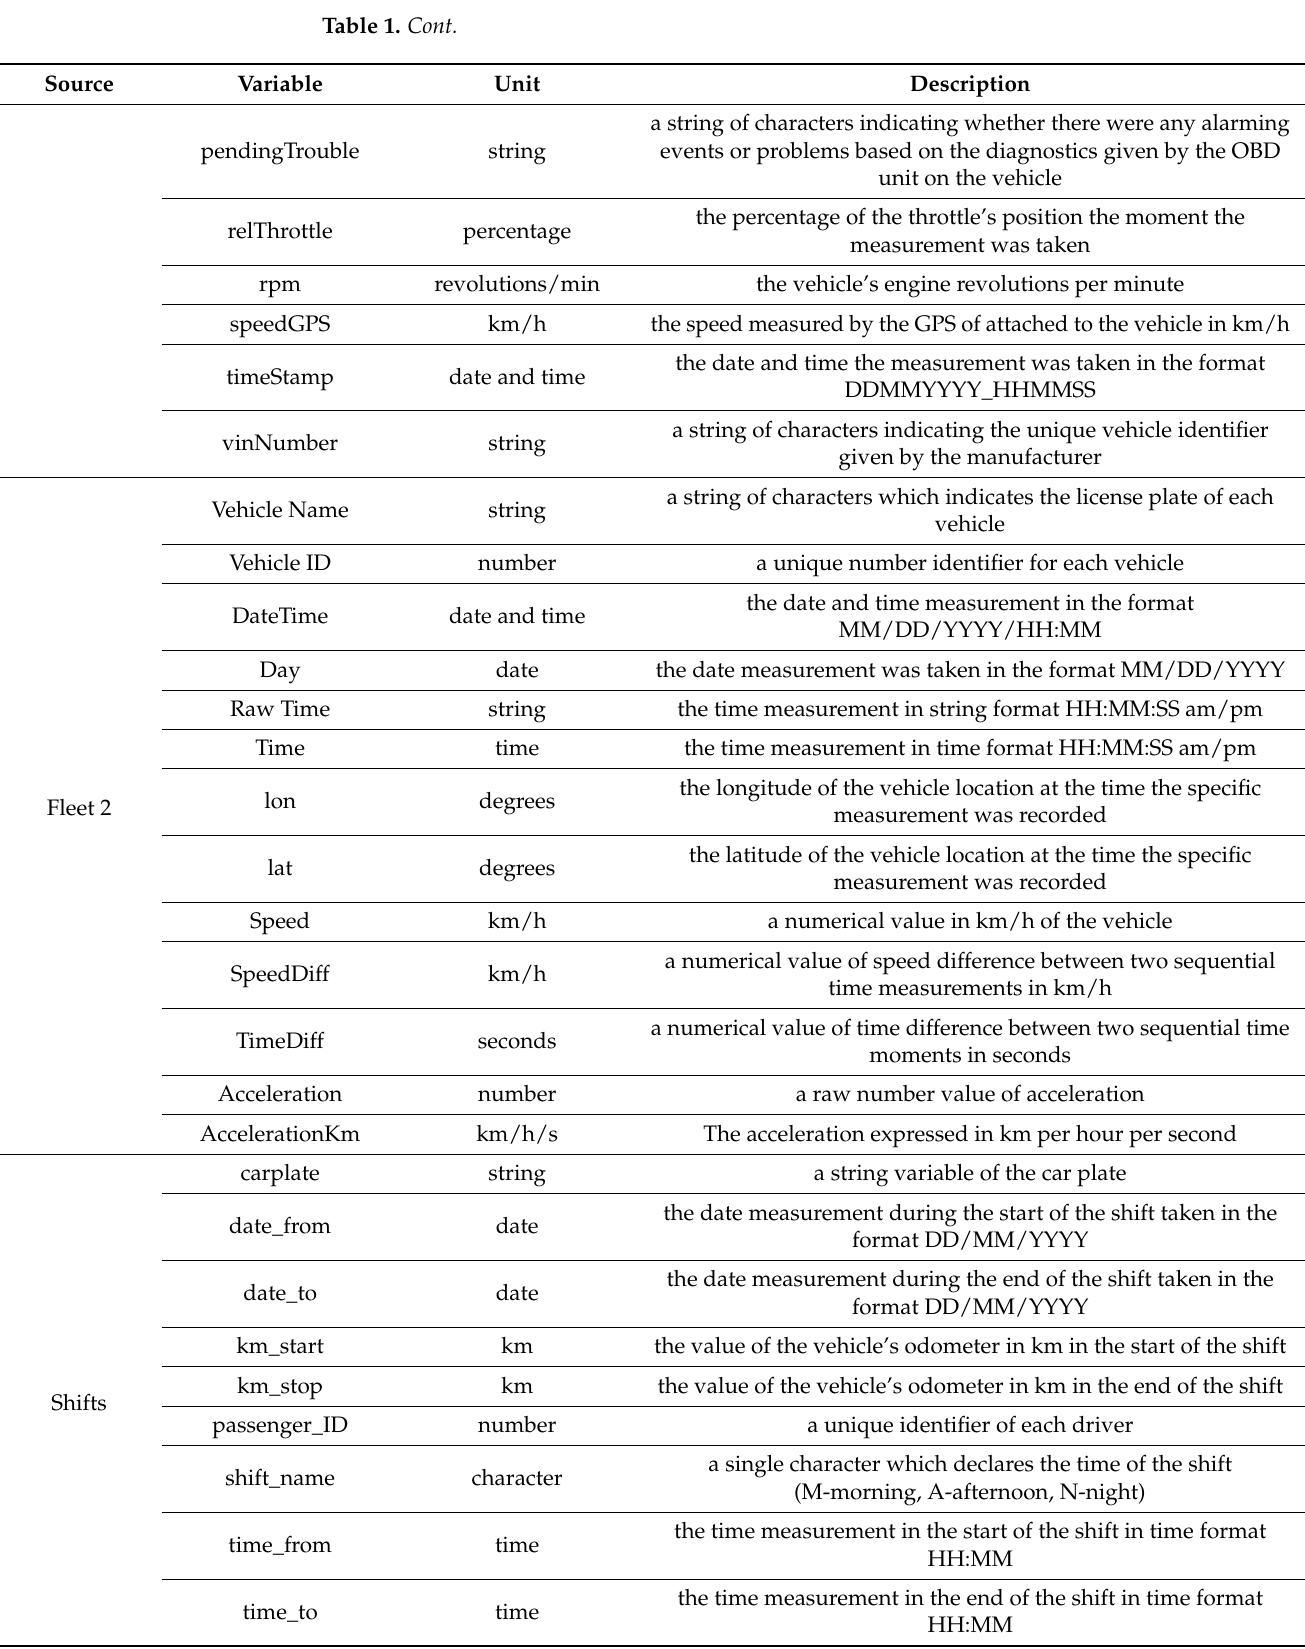
the date measurement during the start of the shift taken in